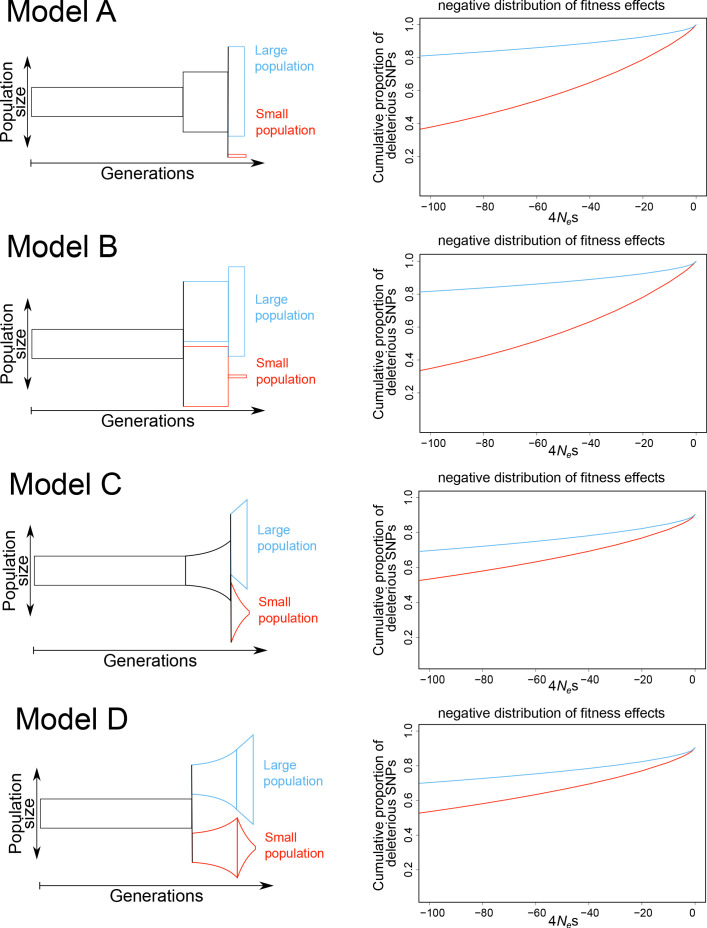
Simulated models with the inferred negative distribution of fitness effects.Simulated demographic models are shown on the left and the inferred negative distribution of fitness effects are shown on the right (large population in blue, small population in red). Models differ after the burn-in phase with either constant population sizes (models A, B) or exponential population de-/increase (models C, D). Models A and C include a shared ancestral population after burn-in phase and models B and D directly split after the burn-in phase. Population size is shown on y-axis and generations are shown on the x-axis. The negative distribution of fitness effects is shown with the cumulative proportion of deleterious SNPs on the y-axis and the compound measure of 4Nes on x-axis.